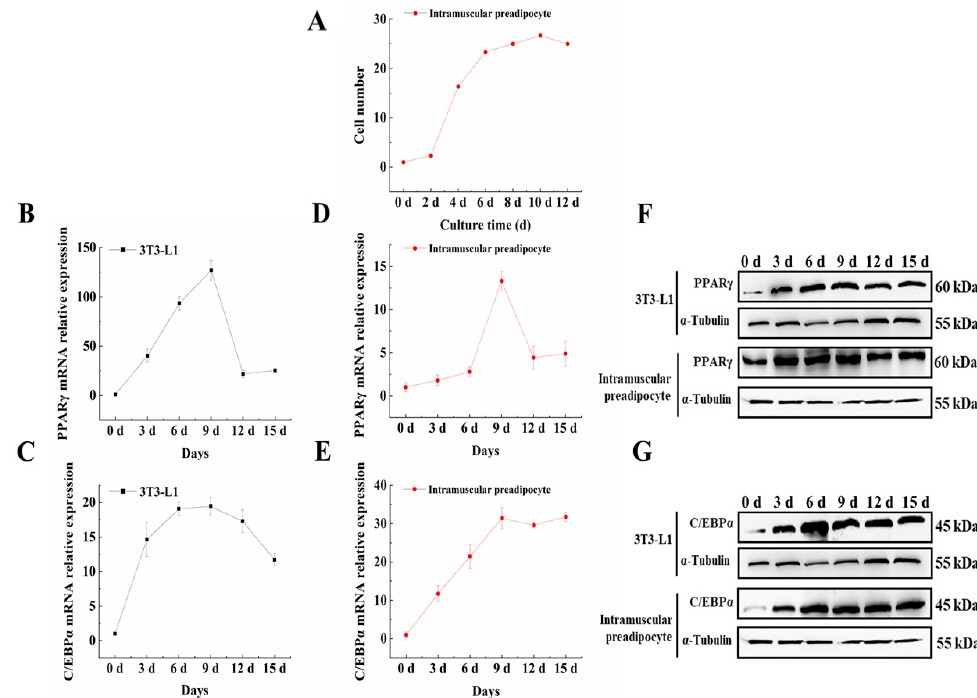
Figure 1. Growth curve of primary cultured bovine intramuscular preadipocyte (BIMP) and identification of adipogenic marker genes. ( A ) Growth curve of BIMP. ( B – E ) Expression of PPAR γ and C/EBP α mRNA during the differentiation of BIMP and 3T3-L1 cells. ( F , G ) Protein expression of PPAR γ and C/EBP α during the differentiation of BIMP and 3T3-L1 cells. RT-PCR data was normalized to day 0.